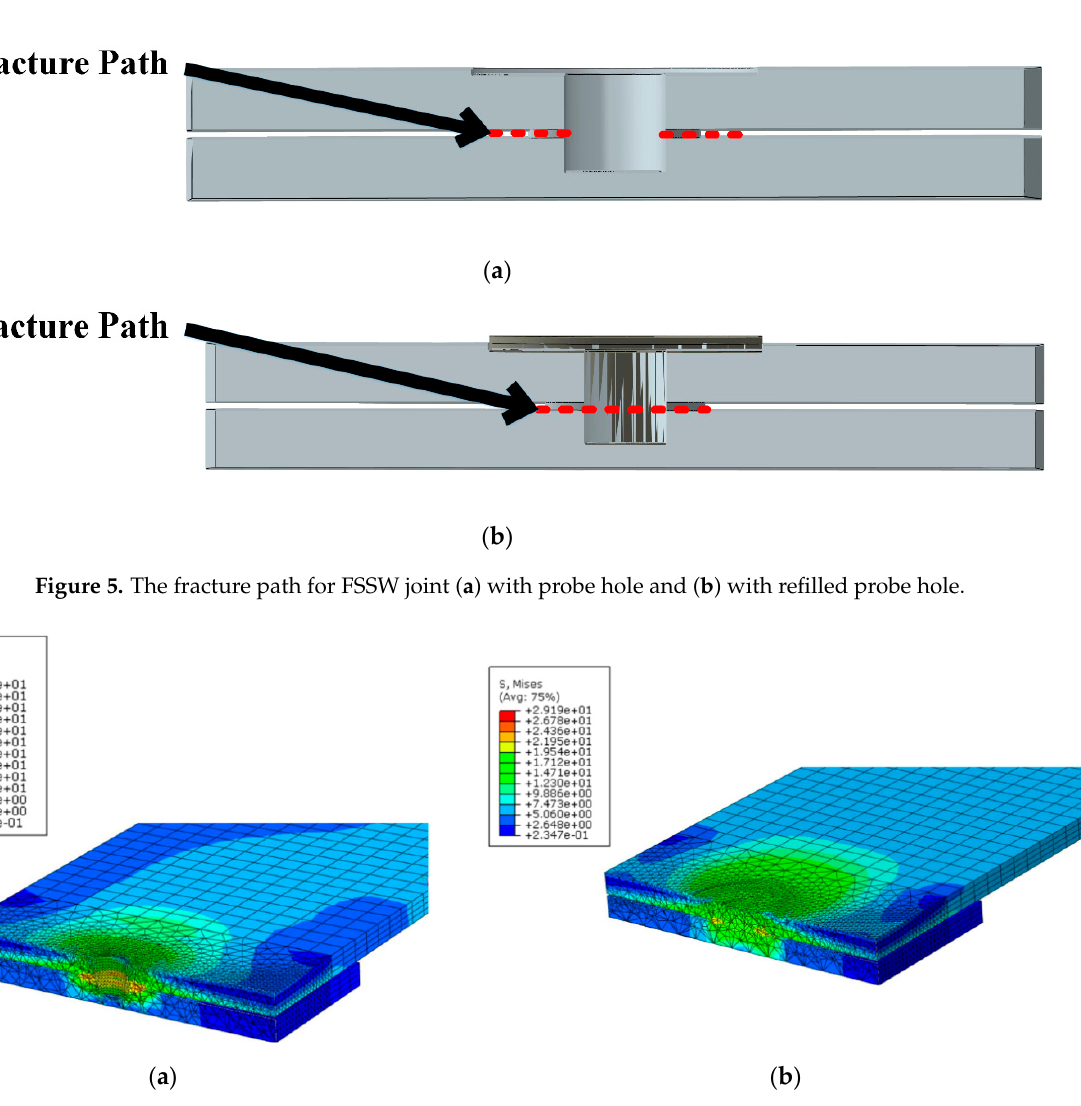
Figure 6. The stress distribution around the hole in a model with ( a ) probe hole and ( b ) refilled probe hole (stresses are in MPa).